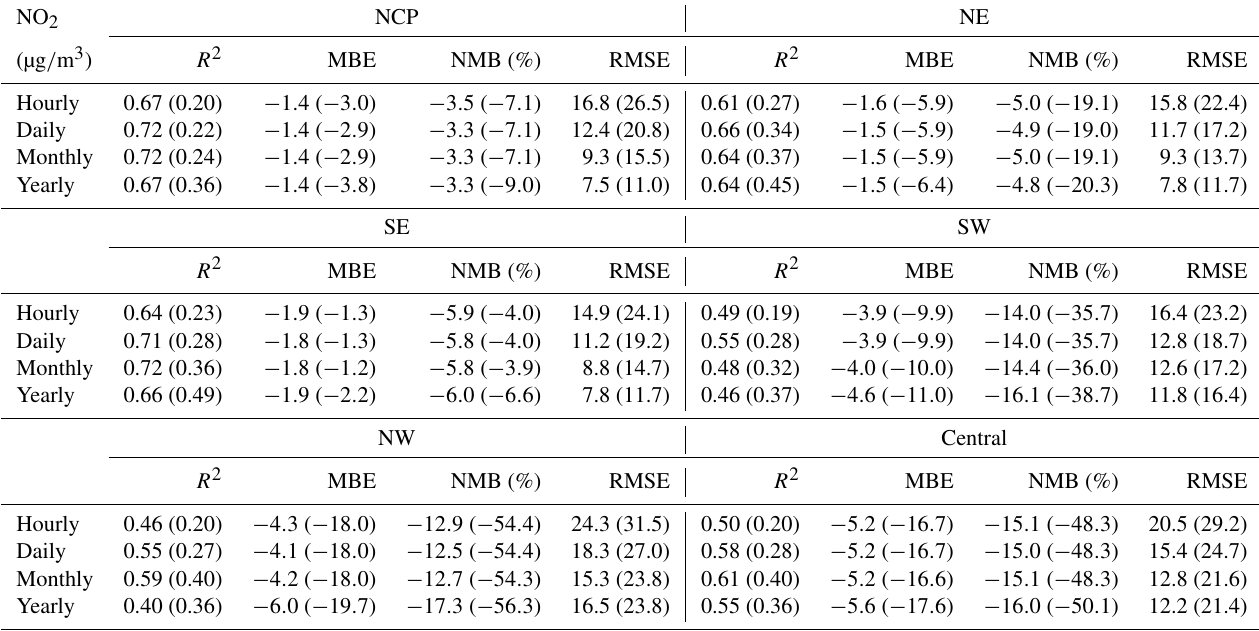
Table E4. CV results of the reanalysis (outside brackets) and base simulation (in brackets) for NO 2 concentrations in different regions of China on different temporal